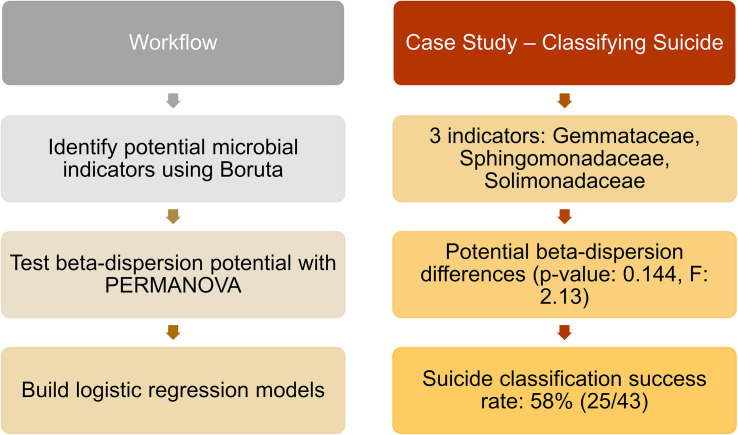
Proposed workflow with suicide matched-design case study. Left column indicates potential steps researchers and practitioners can follow for future studies. Right column provides results from the matched-design case study, following the workflow. Twenty-three suicide cases were matched by age, sex, and race with other deaths (natural, homicide, and accidental), and nose samples were included in the analyses. Indicator taxa were identified by Boruta, while beta-dispersion was calculated using UniFrac distances and tested with PERMANOVA. A logistic regression model of beta-dispersion was constructed to classify suicide vs. non-suicide deaths.